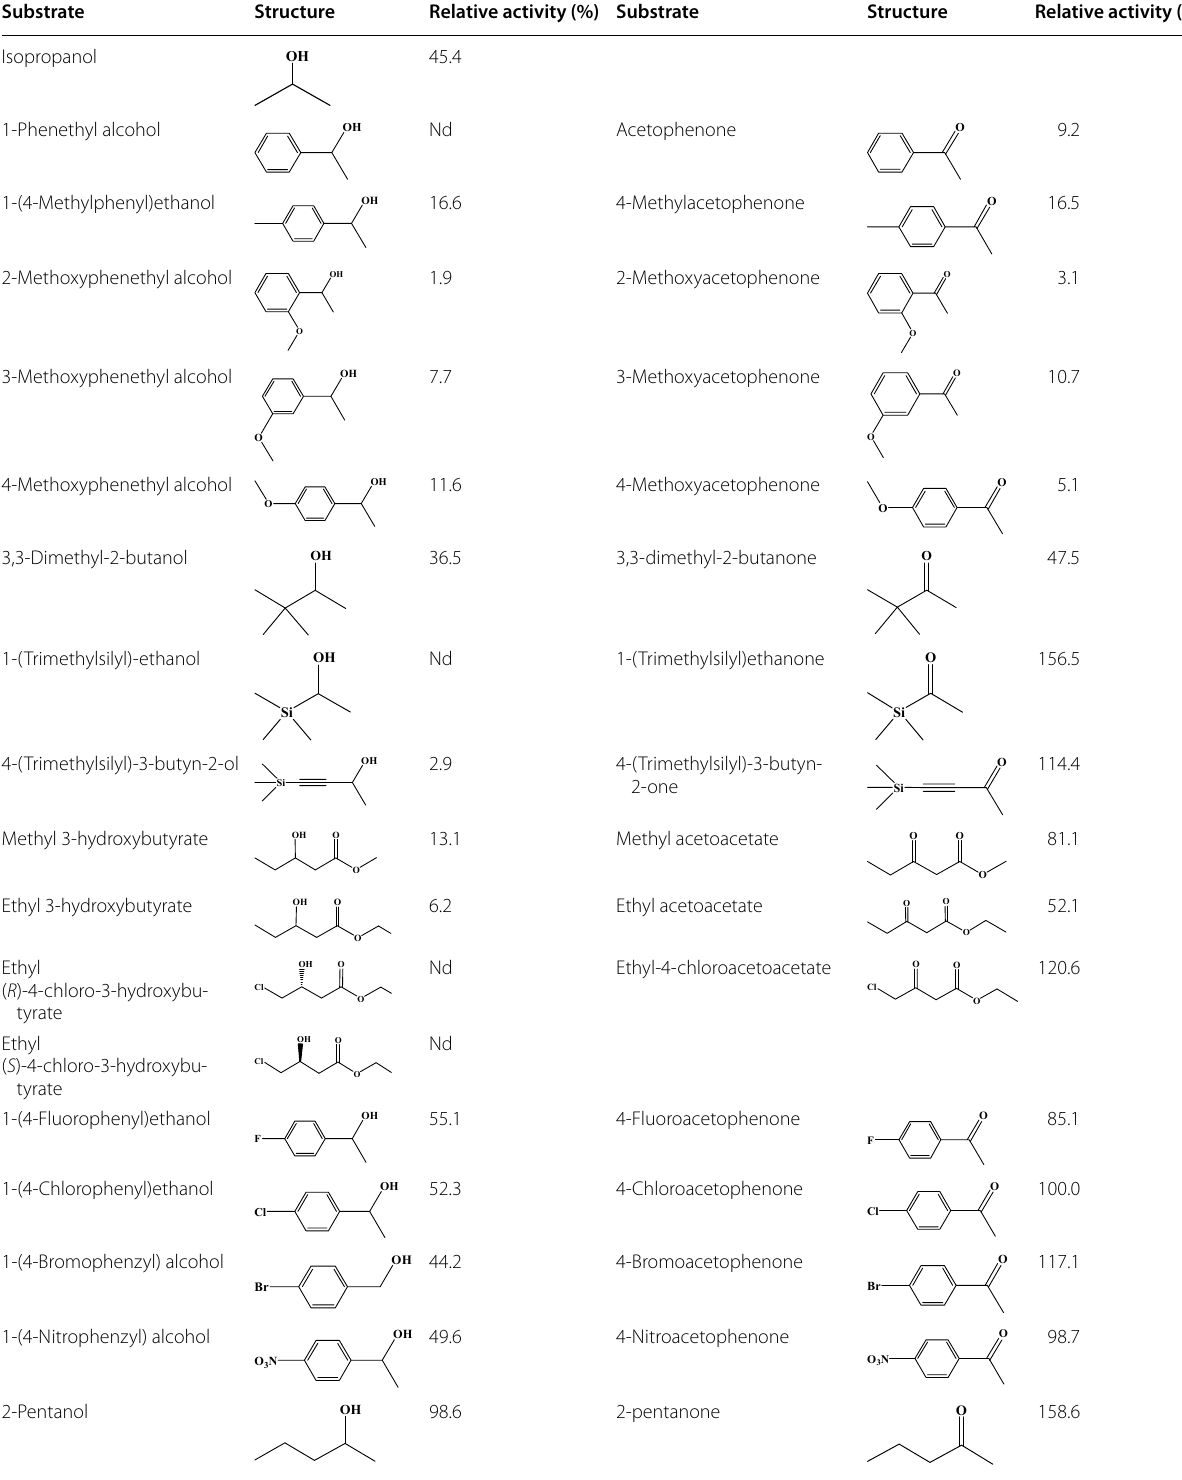
Table 3 The relative activity of the recombinant AcCR to catalyze the oxidation of alcohols and reduction of ketones Substrate Structure Relative activity (%) Substrate Structure Relative activity (%) Isopropanol OH